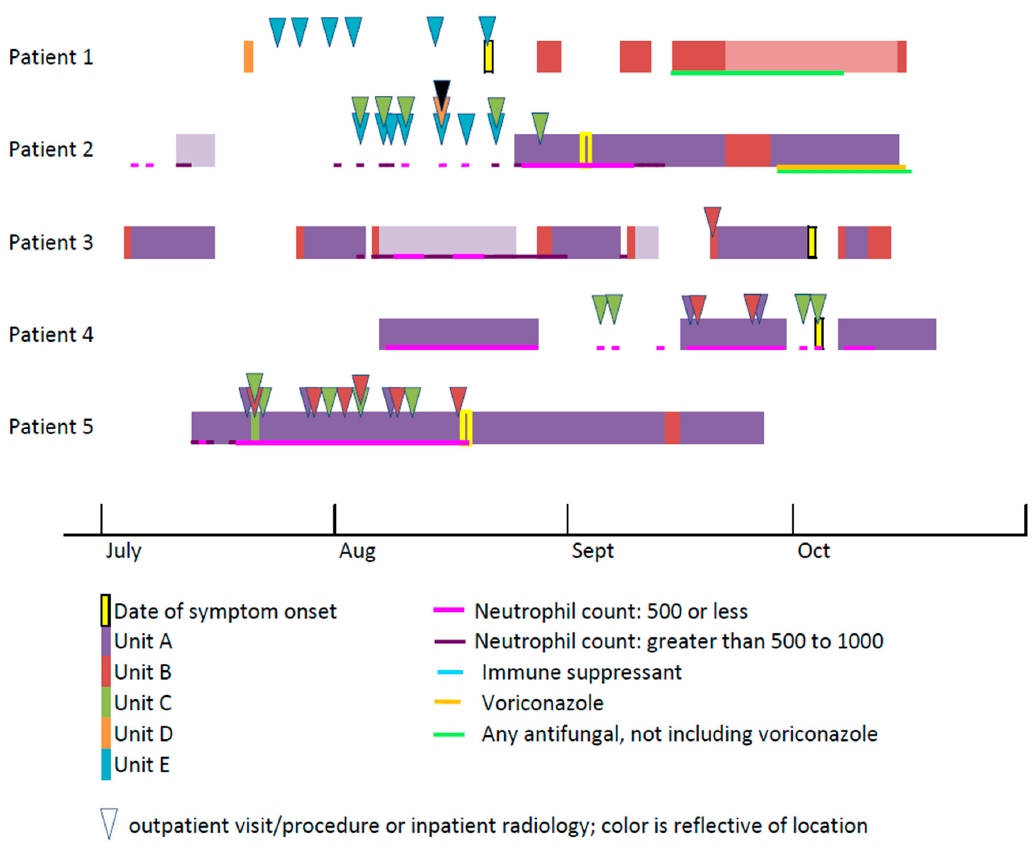
Figure 3. Sample timeline of inpatient locations and outpatient visits. Each of the five lines represents a di ff erent patient. Outpatient visits are depicted with a triangle color-coded by location. Days in each inpatient unit are depicted by color-coded bars. The lines under the bars show days the patient was immunosuppressed and received antifungal medication.